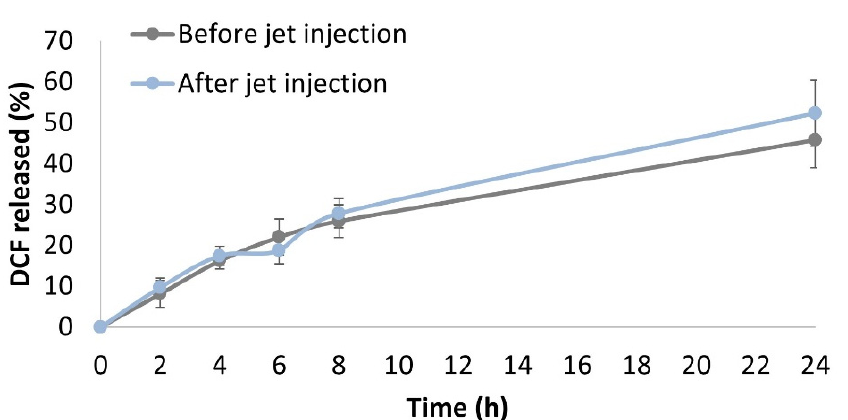
Figure 5. Drug release from the DCF nanocrystals before or after jet injection in a gel matrix sim- ulating the subcutaneous tissue. Points represent the average of n = 3 independent experimental de- terminations.